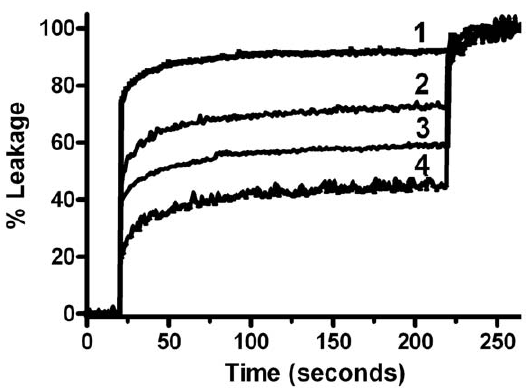
Figure 5. Phosphocreatine and creatine protect lipid vesicles against melittin-induced permeabilization. 50 m M of CH/POPE/ POPC/SP-LUVs entrapping a quenched ANTS/DPX solution were injected into PIPES buffer (20 mM pH 7.4, isomolarity of the entrapped solution was adjusted to be equal to that of the external media with NaCl). The media external to the liposomes contained only phosphate buffer and NaCl (trace 1) or 100 mM DMBG (trace 2), Cr (trace 3), or PCr (trace 4). Leakage was begun with 500 nM melittin. All buffers and